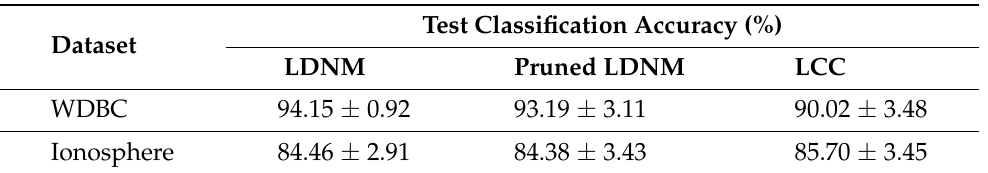
Table 3. The comparison of the test classification accuracy among different classifiers for two problems.